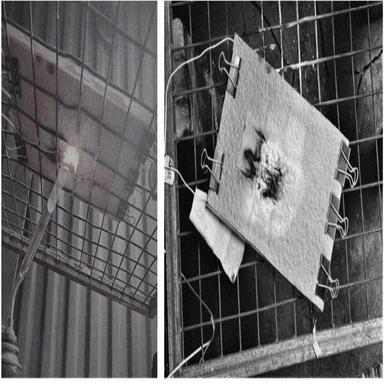
Photo of experimental test setup used for characterizing the considered thermal barrier materials.